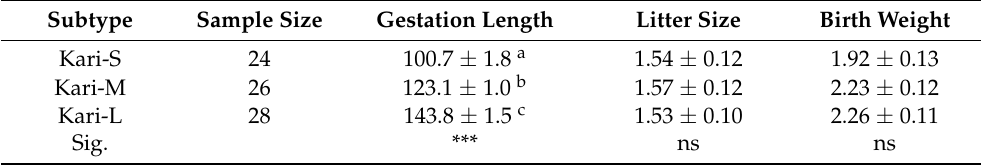
Table 1. Variation in gestation length among the three Kari subtypes and its association with litter size and birth